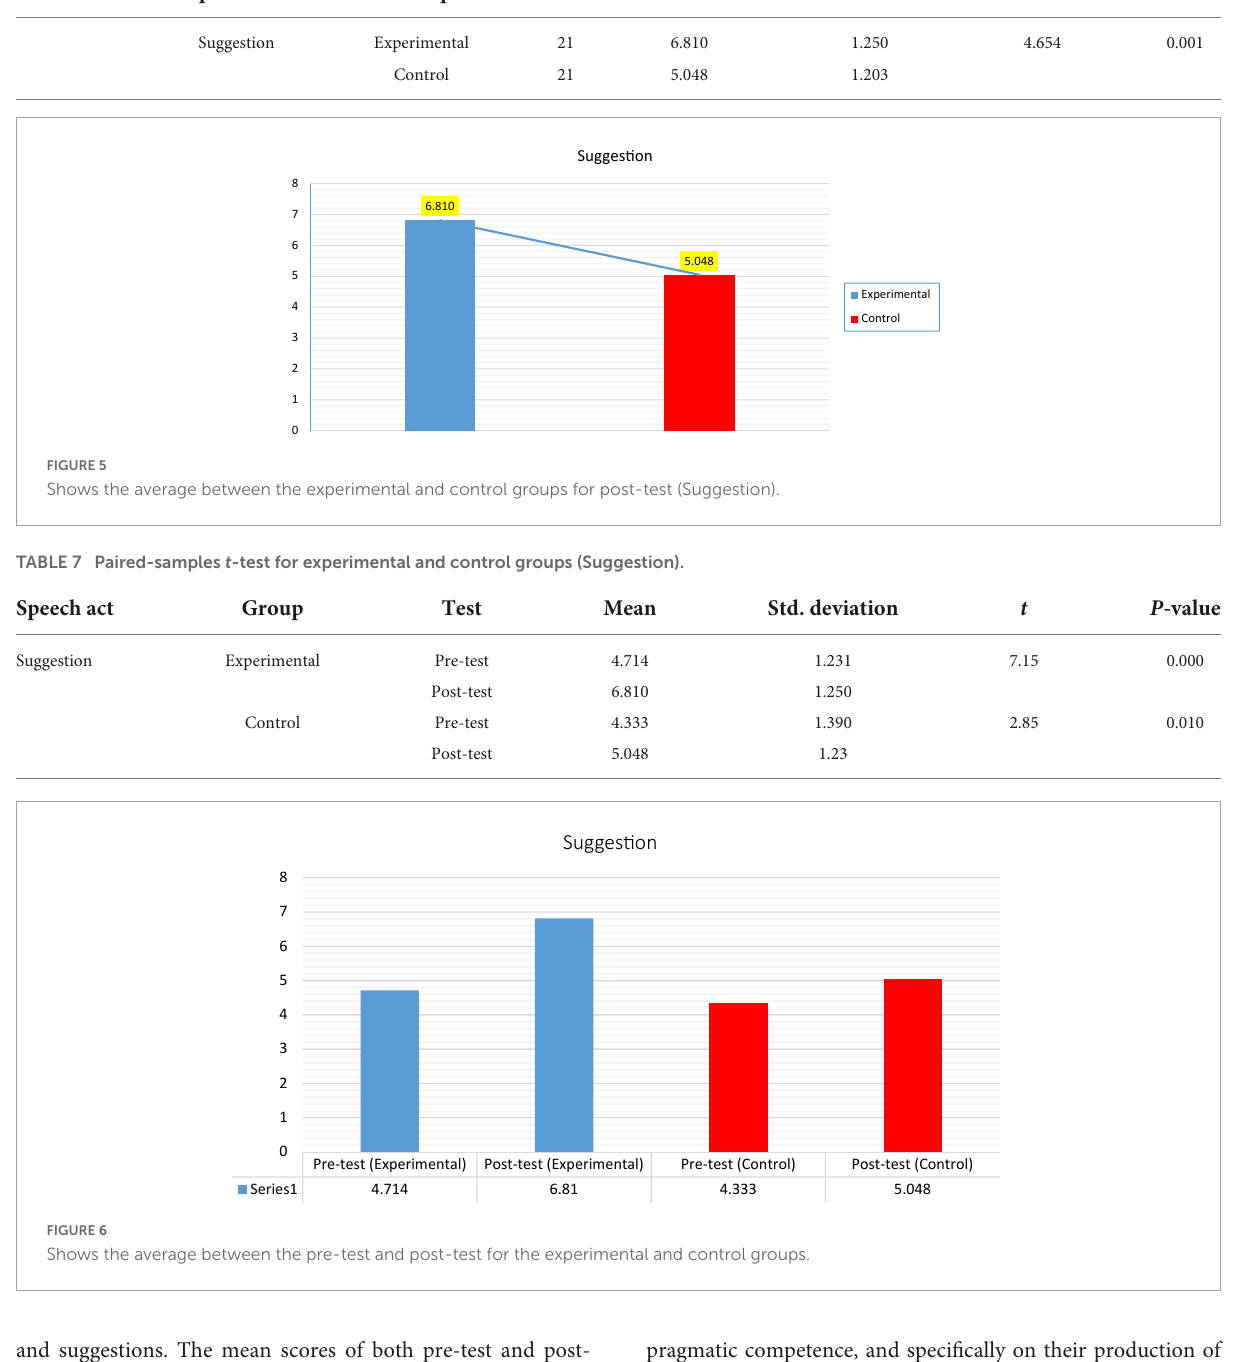
TABLE 6 Independent sample t -test between the experimental and control groups for post-test (Suggestion).